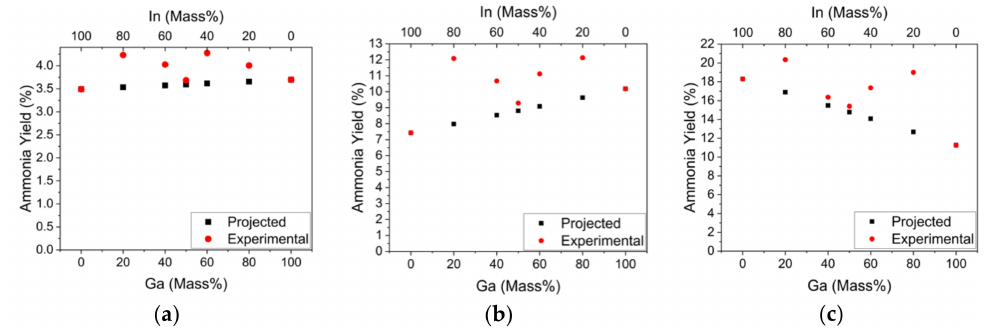
Figure 1. Ammonia yield at steady state (%) vs. alloy composition at various powers ( a ) 50 W, ( b ) 150 W, ( c ) 300